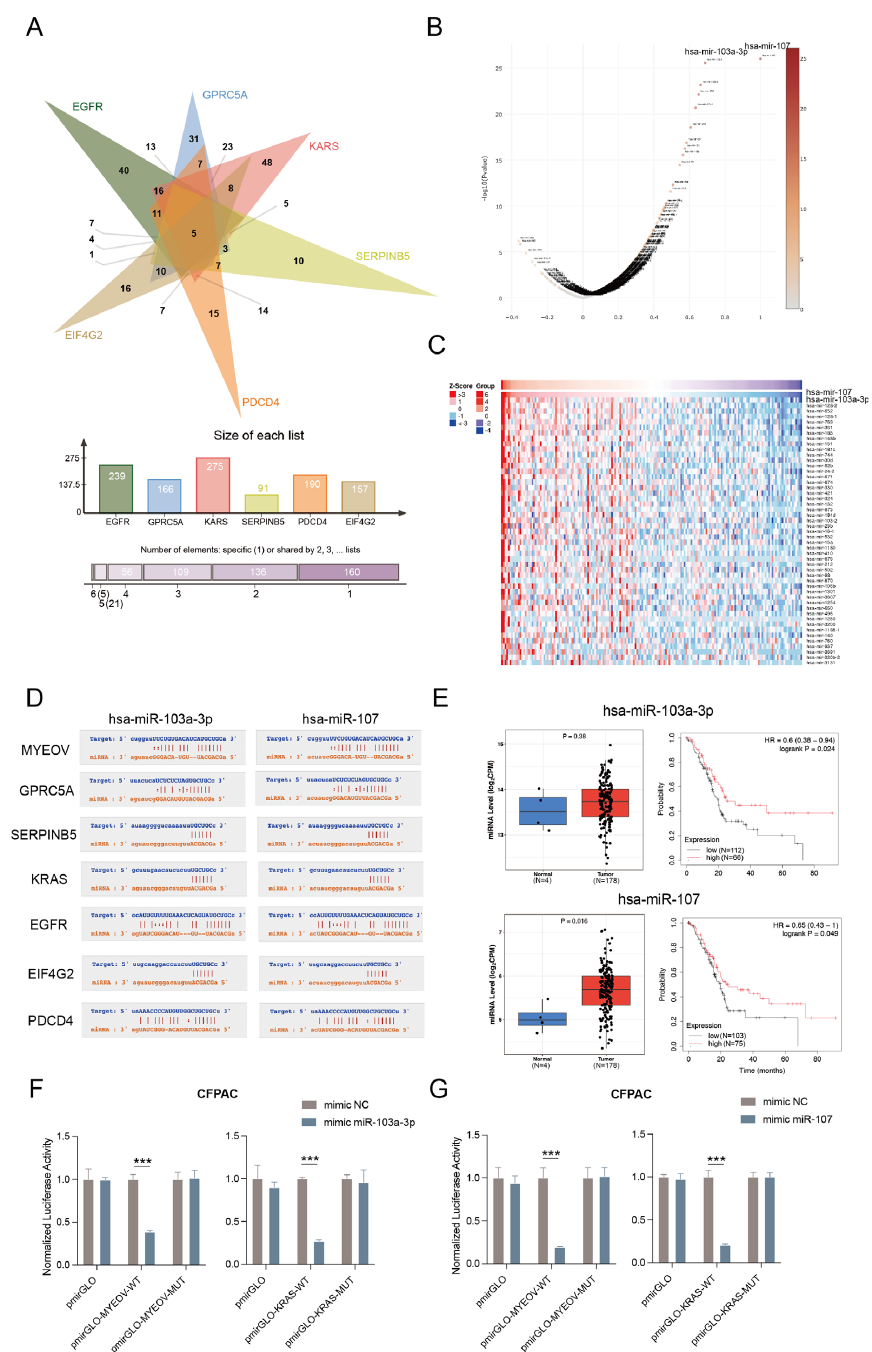
KRAS had protein interactions with genes such as SERPINB5, EGFR, EIF4G2, and PDCD4. The light green lines indicate text mining, the black lines indicate co-expression, the purple lines indicate their relationship was experimentally determined, and the blue lines indicate their relationship was from curated databases. ( B ) MYEOV was significantly associated with SERPINB5 by the analysis of the Timer2 database and the GEPIA database. ( C ) MYEOV was significantly associated with EGFR by the analysis of the Timer2 database and the GEPIA database. ( D ) MYEOV was significantly associated with EIF4G2 by the analysis of the Timer2 database and the GEPIA database. ( E ) MYEOV was significantly associated with PDCD4 by the analysis of the Timer2 database and the GEPIA database. ( F ) The subcellular localization of MYEOV, GPRC5A, SERPINB5, EGFR, EIF4G2, and PDCD4 proteins.